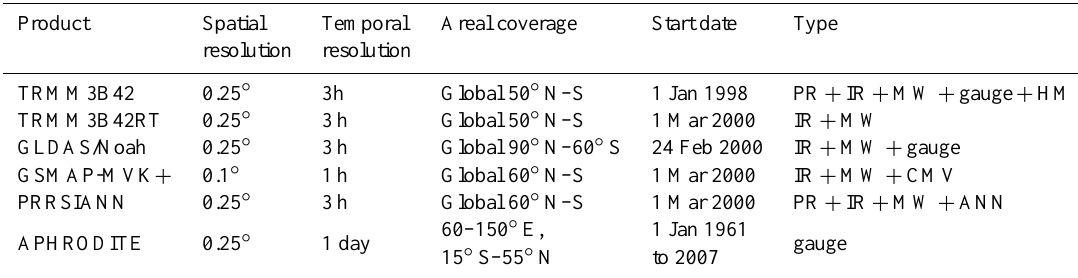
Table 1. Precipitation products.